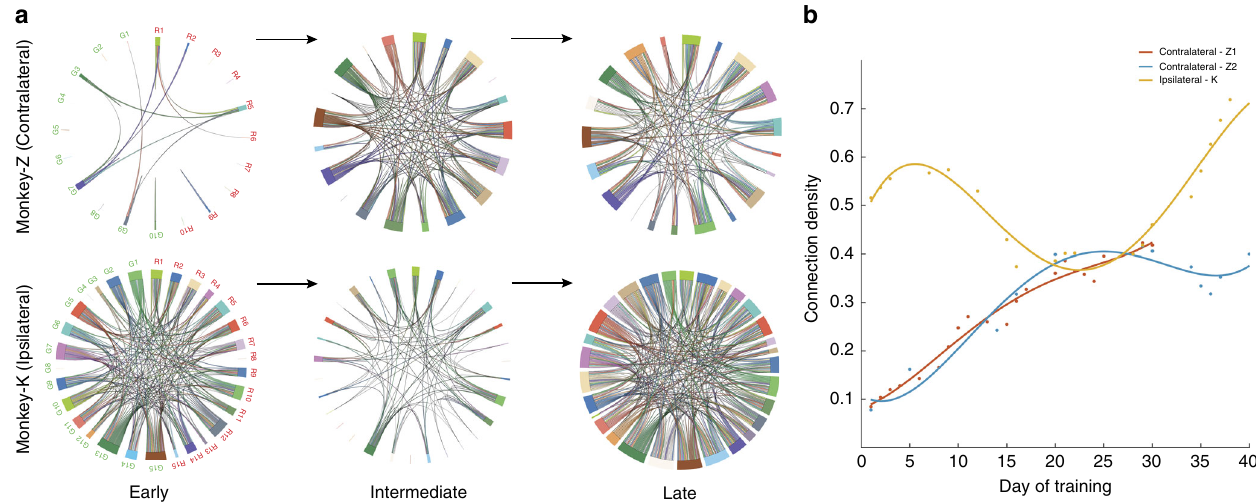
Fig. 2 Network density in the neuronal populations. ( a , Top) Three instances along the days of training shows a monotonic increase in network connectivity in the contralateral monkey Z (contralateral-Z2). Each chord represents a connection between two neurons. ( a , Bottom) shows the connectivity in the ipsilateral monkey K. There was an initial decrease in the network density followed by an increasing phase. Different colored chords represent individual neurons. The labels R n (red) and G n (green) correspond to the reach and grasp neurons, respectively. b The connection density along the entire course of training for two experiments with monkey Z and one experiment with monkey